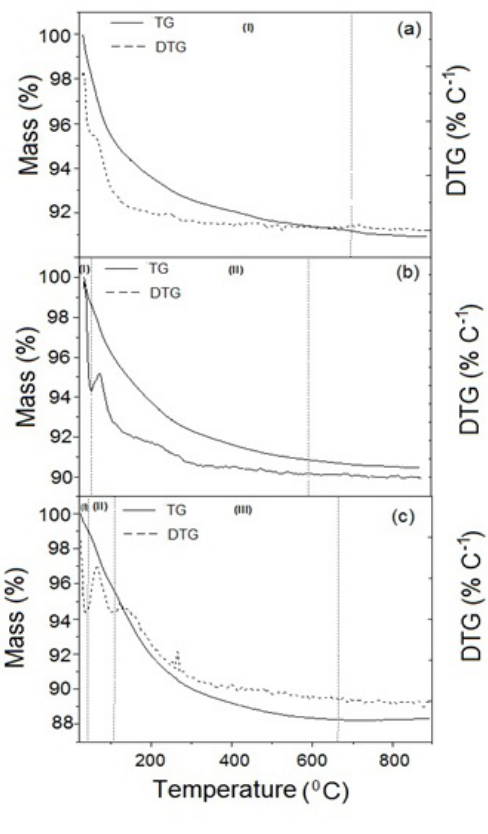
Fig. 4. TG/DTG curves for the non-calcined TiO where: (a) 5% of Ti, (b) 10% of Ti and (c) 15% of